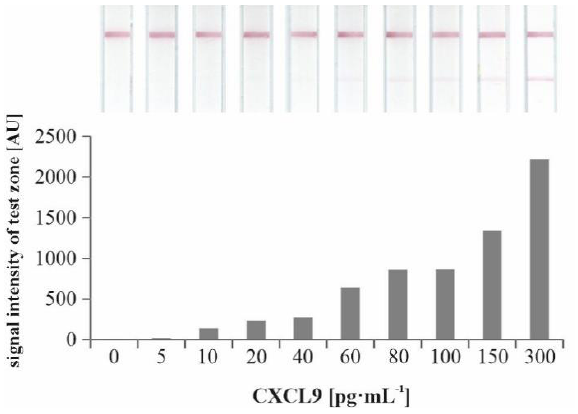
Figure 6. Lateral Flow Assays using different concentrations of purified CXCL9 in pooled urine samples of patients with unsuspicious finding proven by biopsy and binding buffer (1:1) with the corresponding columns reflecting the signal intensity of the test line. Scans were taken 45 min after sample application. N = 1.